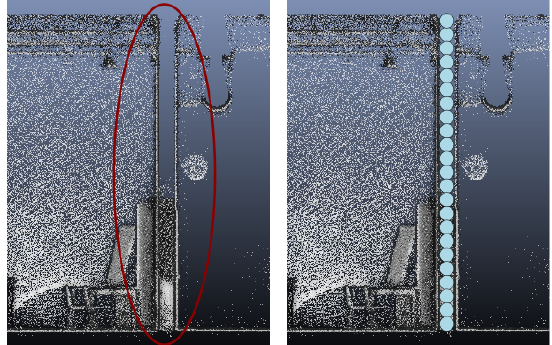
Figure 6. Left: empty space in wall scanned on both sides, right: some medial balls formed inside the wall